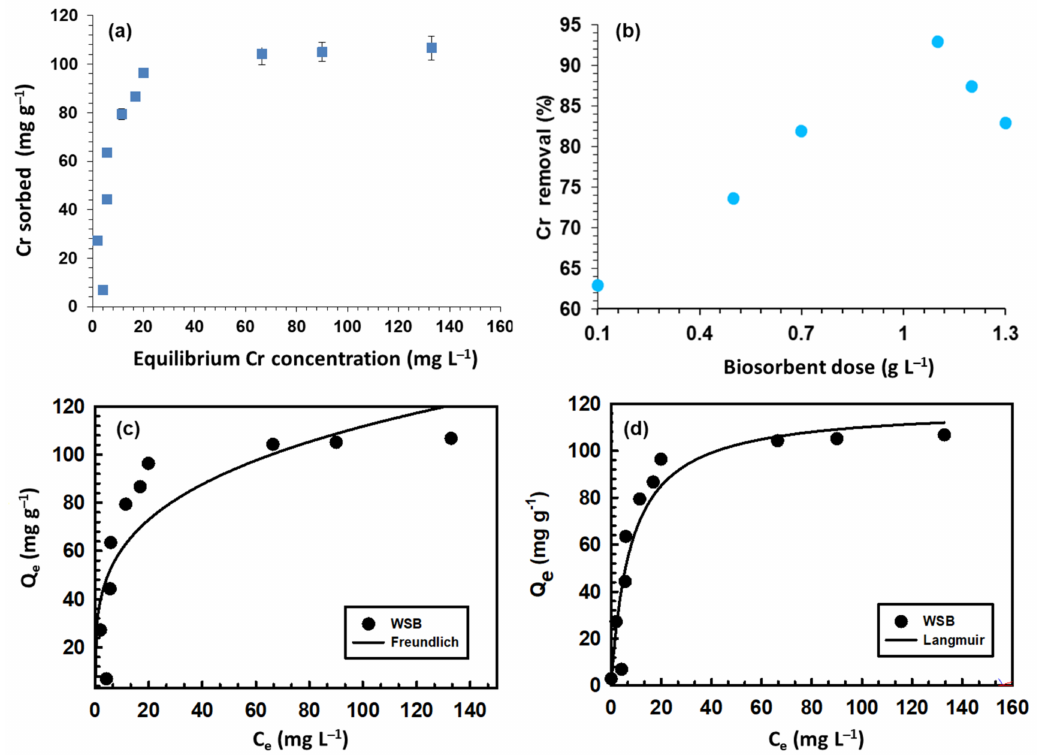
Figure 2. Adsorption of chromium on walnut shell biochar: ( a ) initial sorbate concentration effect; ( b ) biosorbent dose effect; and ( c , d ) isotherm modeling of equilibrium